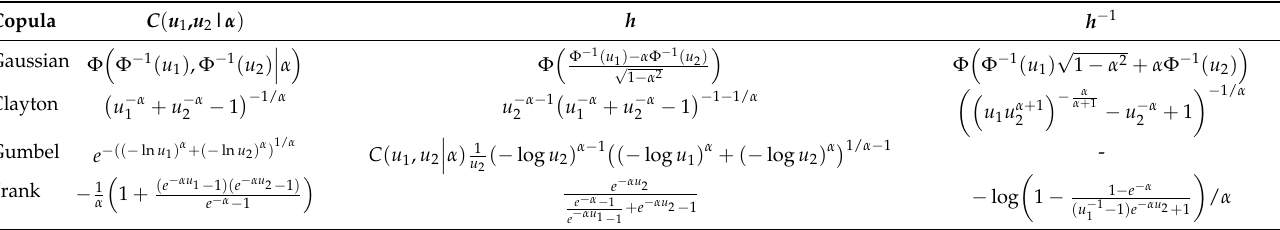
Table 1. The functions h and h − 1 of some frequently-used copula